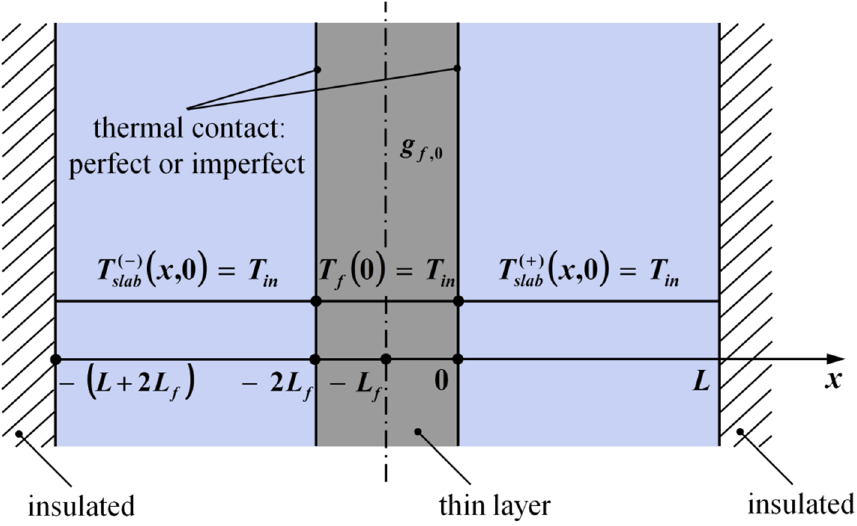
Figure 4. Three-layer structure: thin layer having 2 L f as thickness, in perfect contact with two slabs.